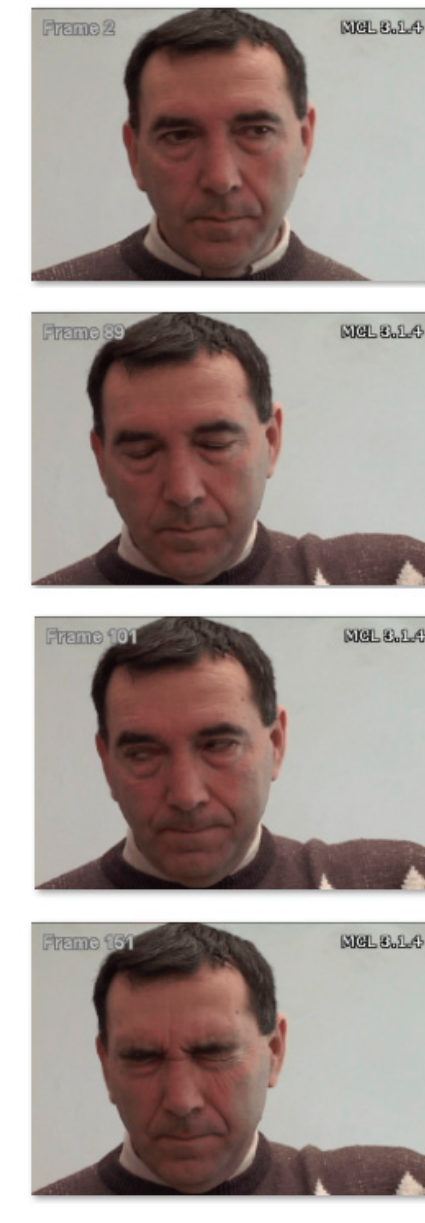
Figure 3. Samples of the UNBC-McMaster shoulder pain expression archive dataset with different levels of pain. Reprinted/adapted with permission from Ref. [10]. Copyright (@jeffery Cohn).